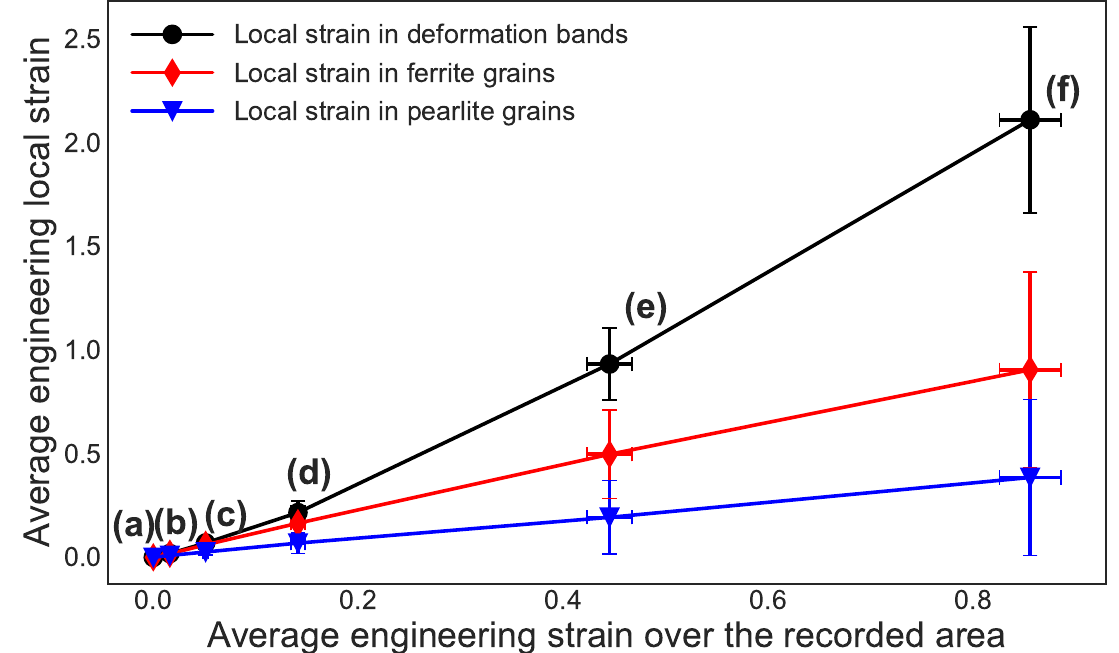
Figure 9. Local strain evolution in pearlite and ferrite grains and the localized deformation bands marked in Figure 8f. The grains selected for the local strain measurements are indicated with blue squares and red diamonds in Figure 10a for pearlite and ferrite, respectively. The average engineering strain over the recorded area are measured using the vectors in Figure